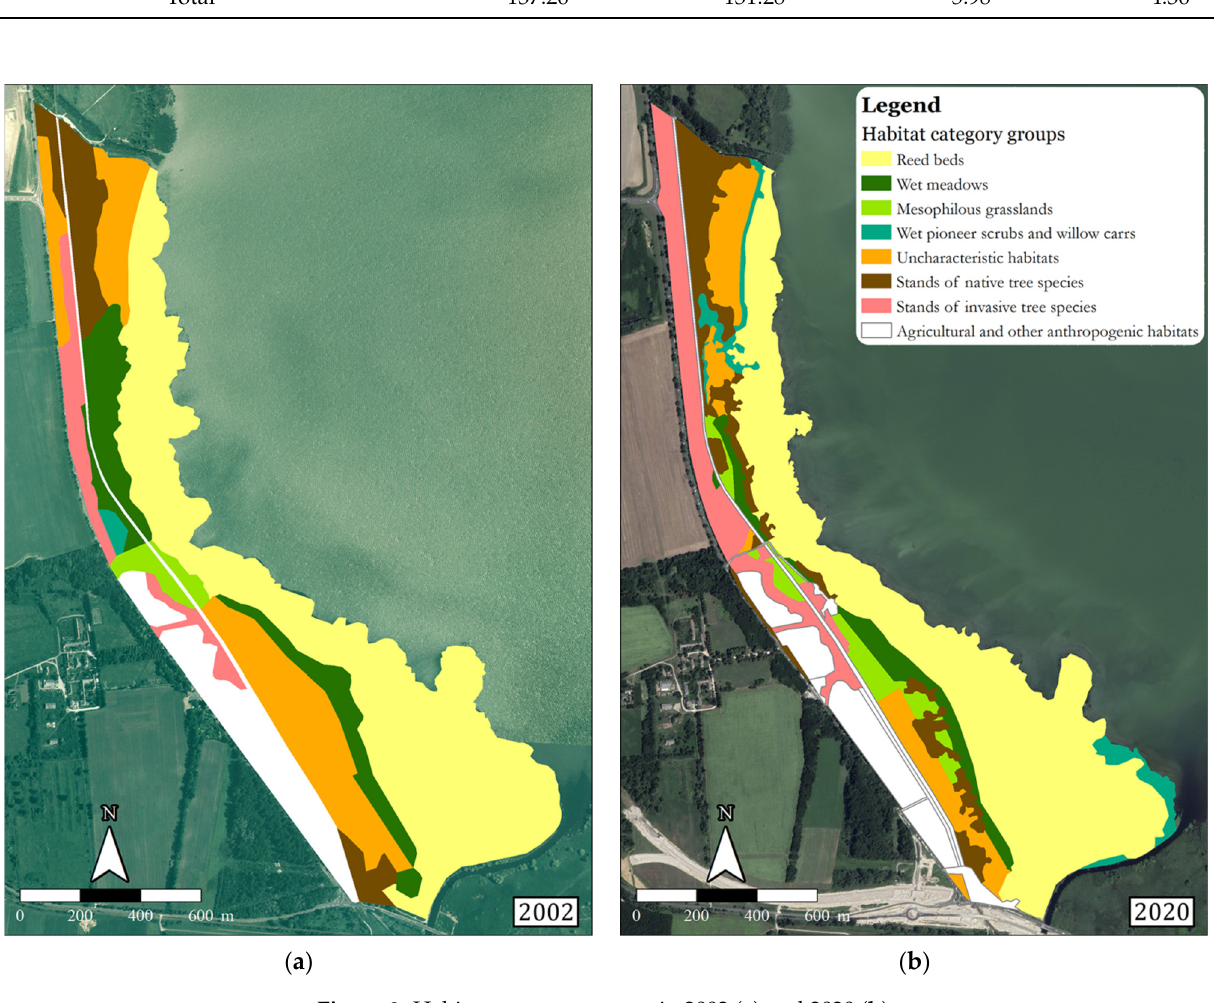
Figure 3. Habitat category groups in 2002 ( a ) and 2020 ( b ). Table 1. Area changes of the habitat type categories between 2002 and 2020.